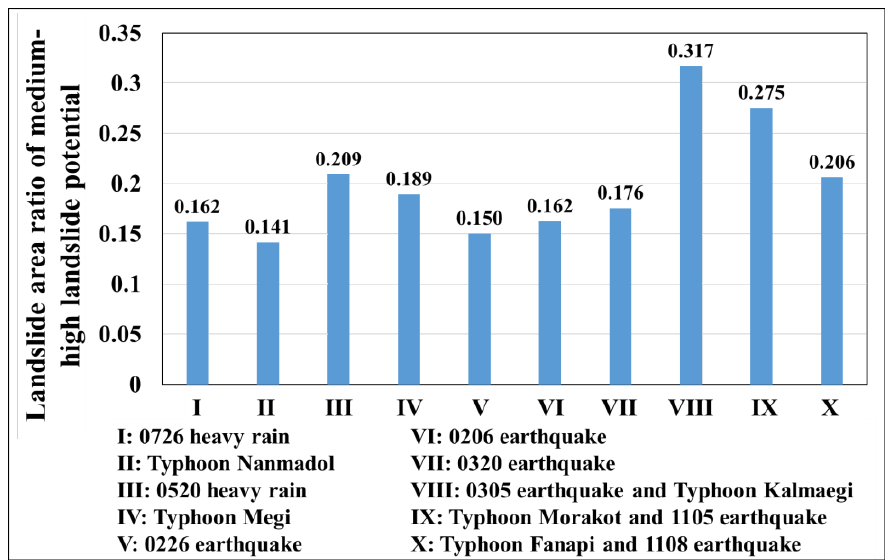
Figure 12. Landslide area ratio of medium – high-level landslides induced by rainfall and earth- quakes in Alishan Township.